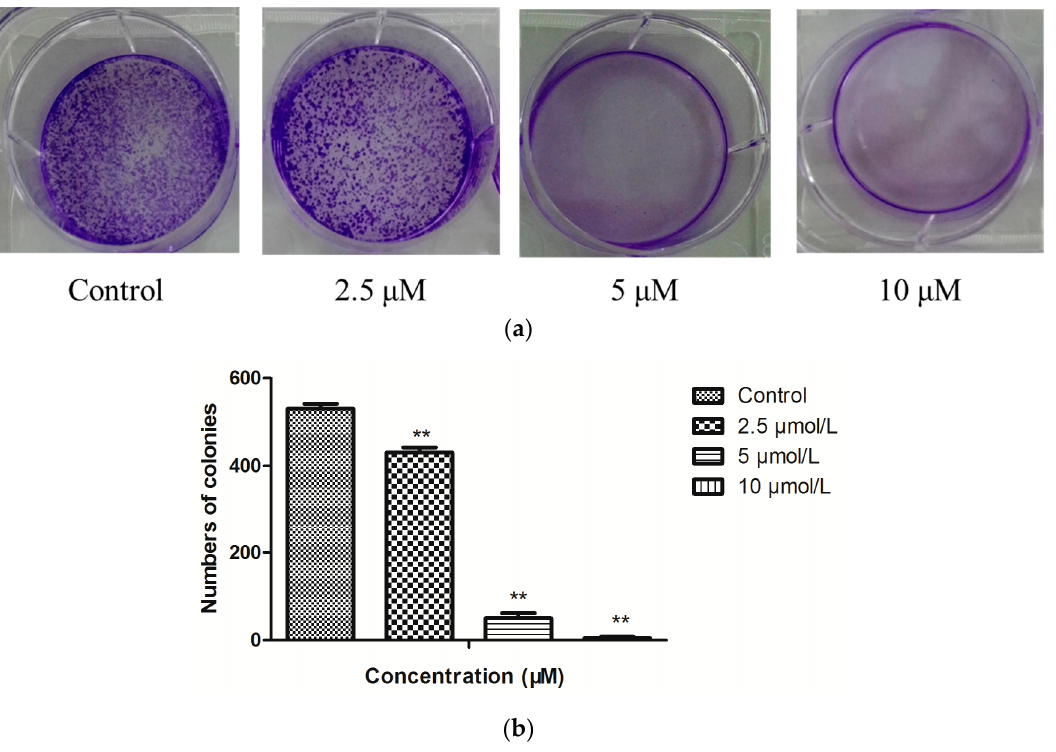
Figure 2. ( a ) Representative images of plate colony formation of HepG-2 cells after treatment with 1b in different concentrations. ( b ) The quantitative analysis of plate colony formation of HepG-2 cells. n = 3; ** p < 0.01.